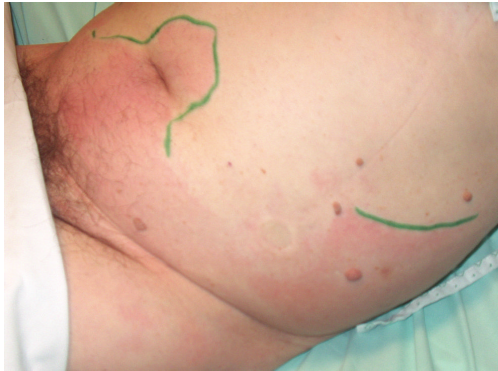
Figure 3: Zone of reddishness expanded up to the flanks